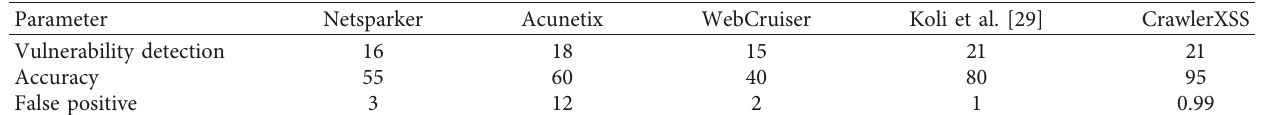
Table 3: Summary of performance